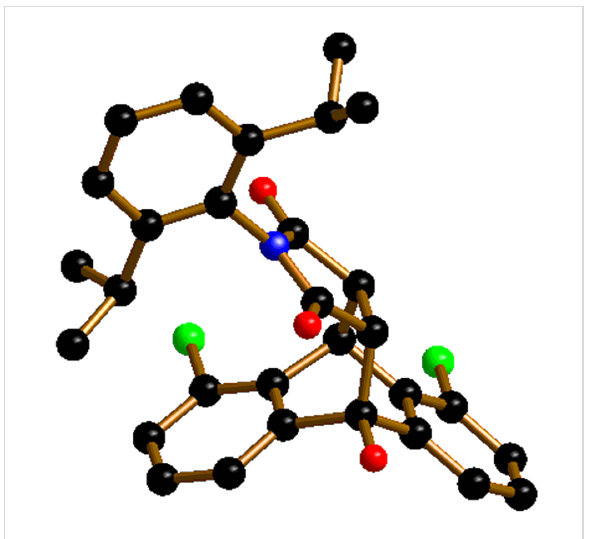
Figure 2: Molecular structure of 3m (C: black; N: blue; O: red; Cl: green; hydrogen atoms are omitted for the sake of